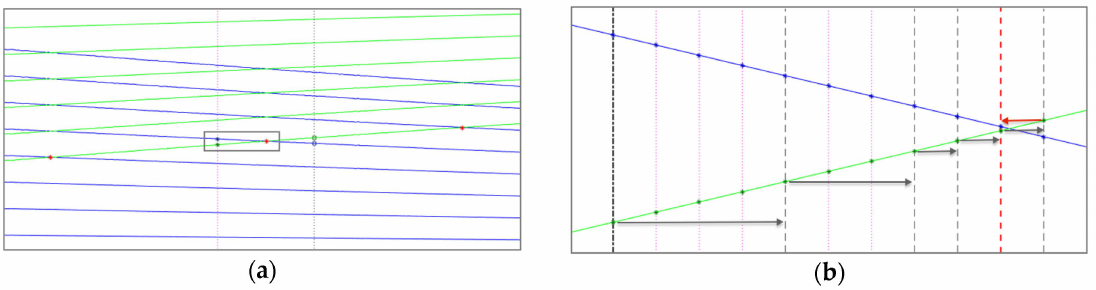
Figure 6. ( a ) Intersection of grid lines of S k (green) and S k ` 1 (blue). Break points are shown with red asterisks; ( b ) Iterative adjustment procedure: black dash-dotted line shows the column with the initial break point approximation; gray dashed lines correspond to intermediate steps of the iterative adjustment procedure with arrows indicating the direction in which adjustments occur, pointing from the current position to the next approximation. The red dashed line is the final position of the break point, which is the approximation before last in the iterative sequence, which continues until the difference between the latitude values changes the